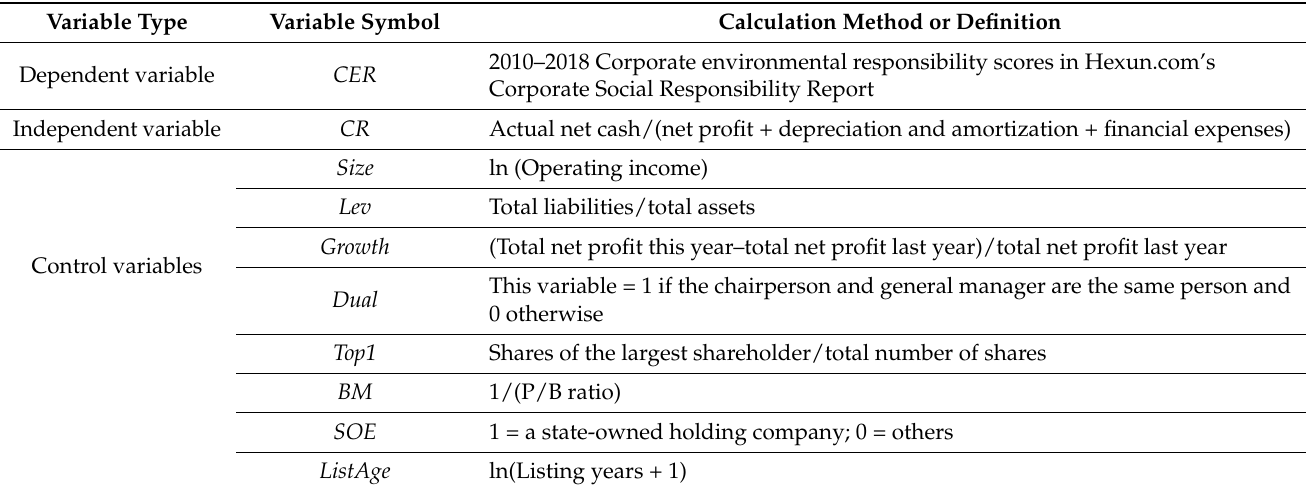
Table 1. Definition and calculation of the